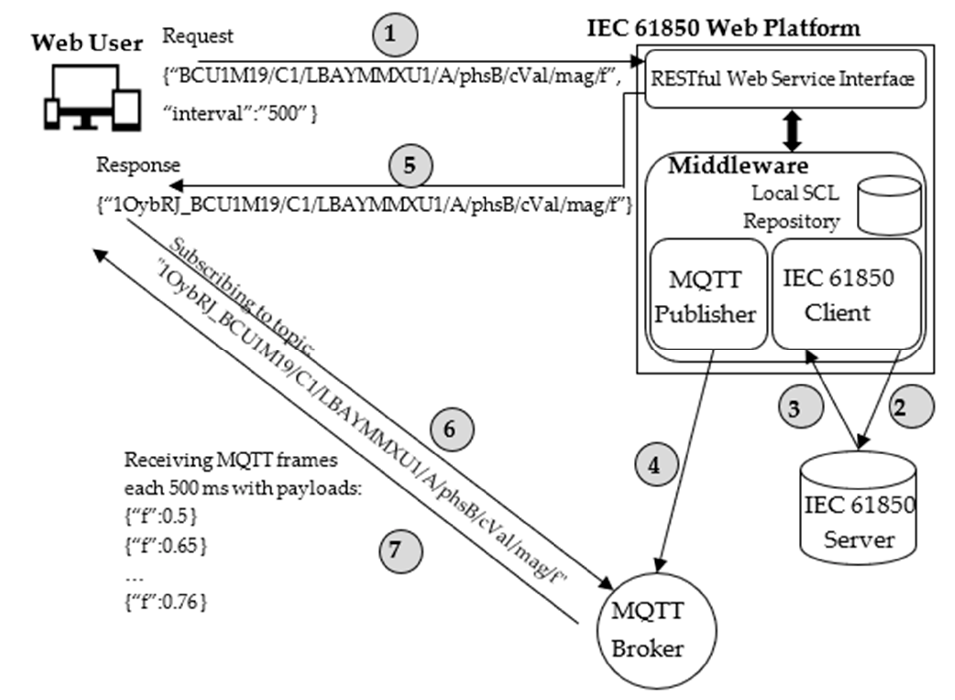
Figure 9. Example of periodic monitoring of a Basic Data Attribute.